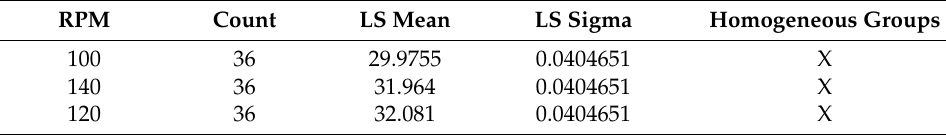
Table 2. Multiple range tests for N-AcG (mg/g) by agitation rpm.